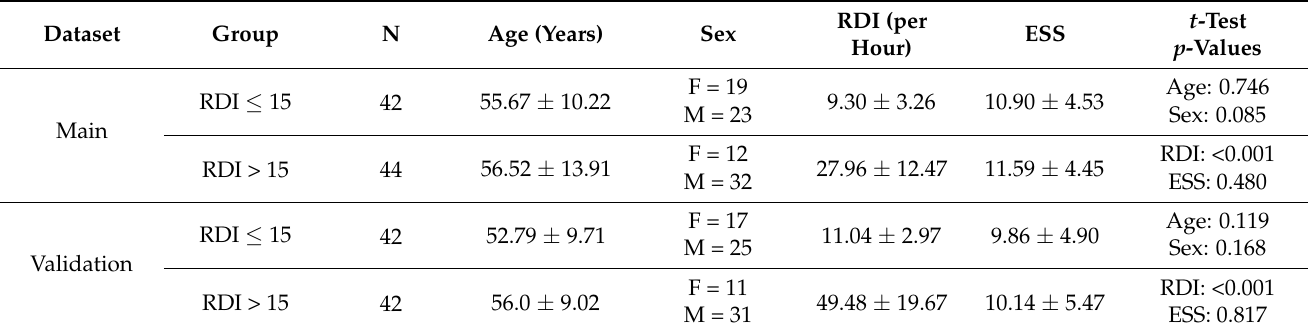
Table 1. Demographic details of all the participants included in the study. Here, RDI: respiratory disturbance index; ESS: Epworth Sleepiness